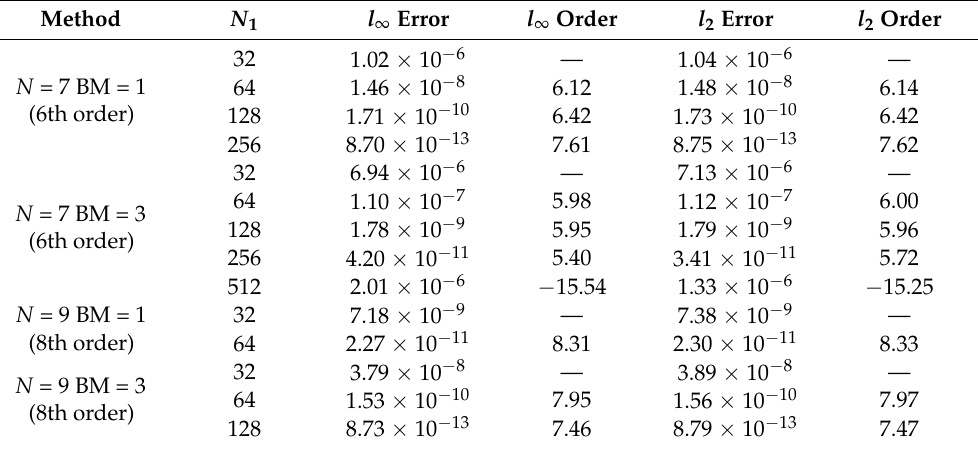
Table 3. Numerical errors and order of accuracy for one-dimensional linear scalar